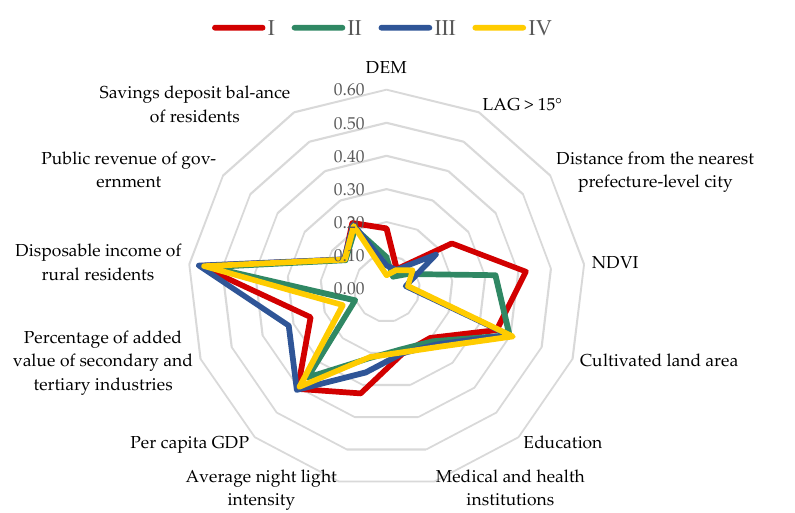
Figure 8. Comparison of the intensity of the poverty contribution ratio. Counties under Category II (green) had a relatively lower PI but its dimension of natu- ral resource was weak. The only problem comes from the environment system. Moreover, the counties were mainly distributed among the suburbs of plain land cities. Within the 62 counties, 18 were relatively substandard counties and 10 were relatively poor counties, which accounted for 29.0% and 16.1%, respectively. The relatively low rate of deterioration in these counties accounted for a relatively large proportion of counties and districts, which indicates the slow industrial development and presence of constant ecological deterioration. Counties under Category III (blue) exhibited a slightly higher PI as well as a higher